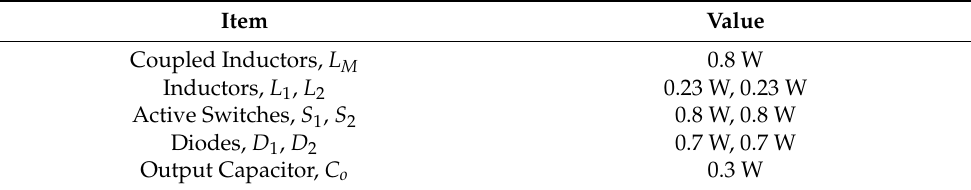
Table 3. Measured losses in the